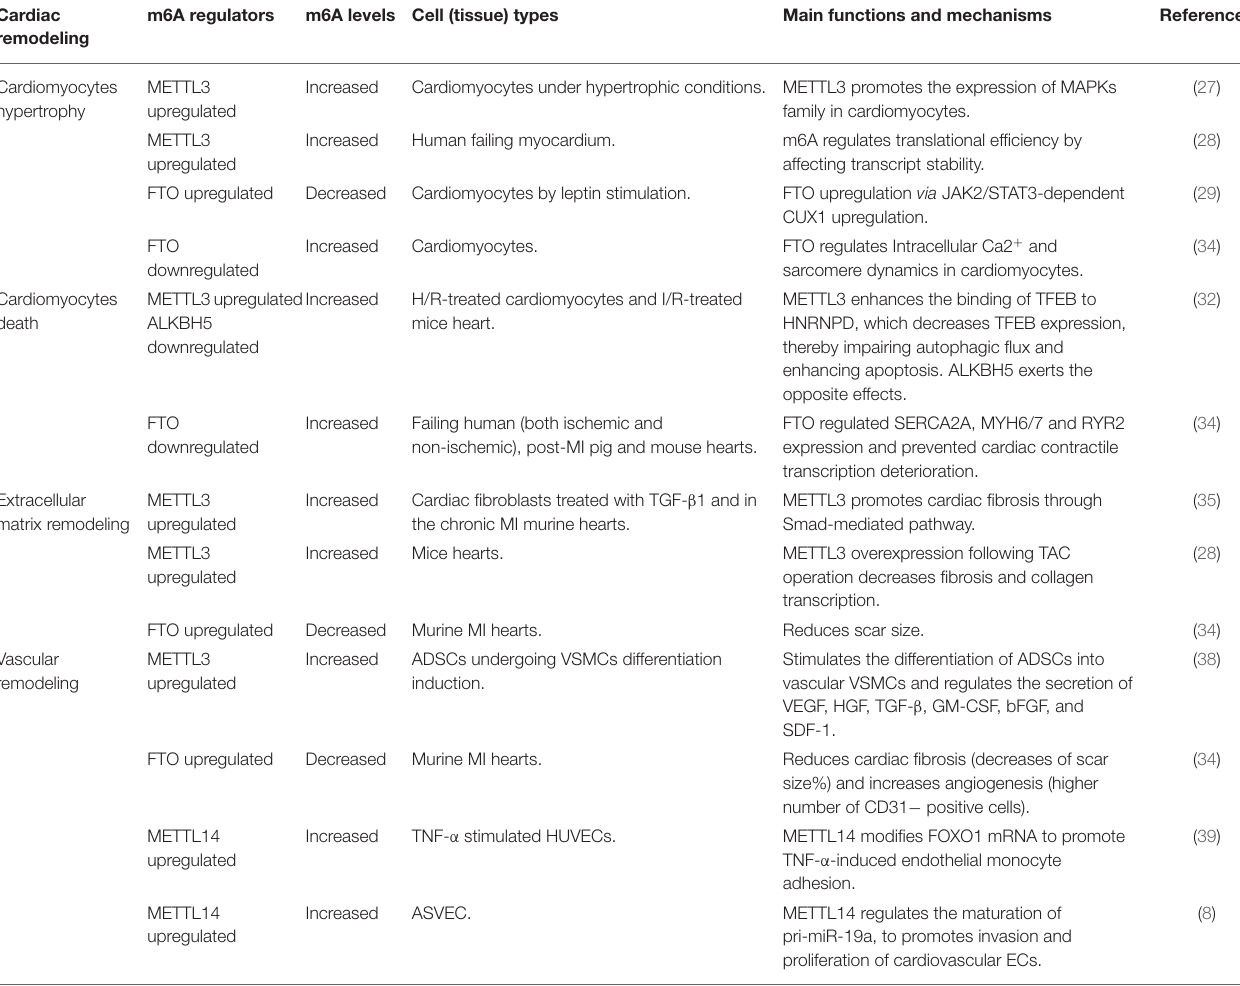
TABLE 1 | Role of m6A modification in cardiac